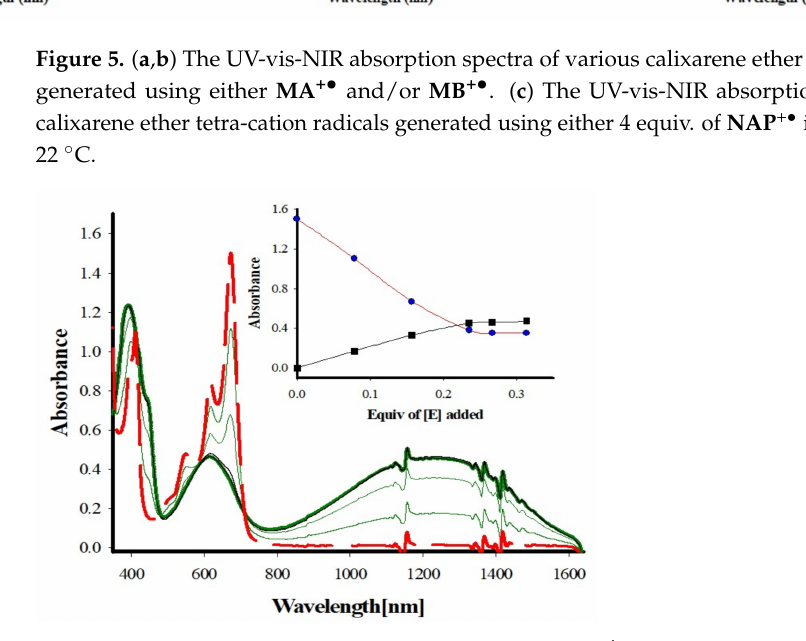
Figure 6. Spectral changes upon the reduction of 1.6 × 10 − 4 M NAP + • (red dashed line) by